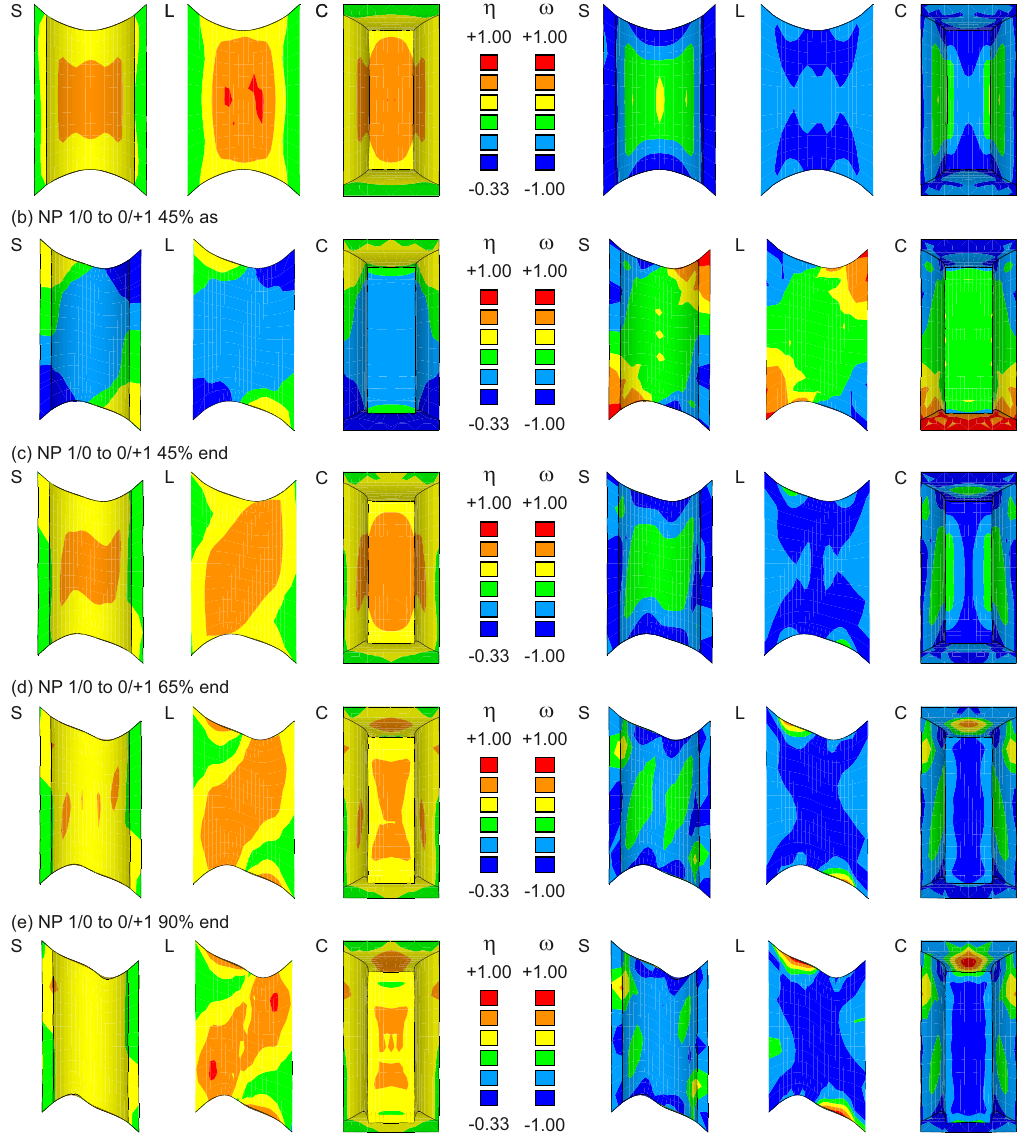
Figure 12. Stress triaxiality η and Lode parameter ω : S—surface, L—longitudinal section, C—cross section. Furthermore, numerically predicted distributions and amounts of the equivalent plastic strain γ and the equivalent damage strain µ on the surface (S) of the notched region, in the longitudinal section (L), and in the cross section (C) for the loading histories EXP 1/0 to 0/+1 are shown in Figure 13. In particular, at the end of the basic experiment with the proportional loading path P 0/+1 end (Figure 13a), the maximum equivalent plastic strain γ = 0.22 occurs on the surface (S) of the notch in a vertical band, whereas, in the center of the notch (L, C), only γ = 0.12 is reached. On the other hand, the equivalent damage strain has its maximum with µ = 0.10 in the center (L, C) of the notch, whereas, on the surface (S), no damage is numerically predicted. For this basic loading case P 0/+1, the